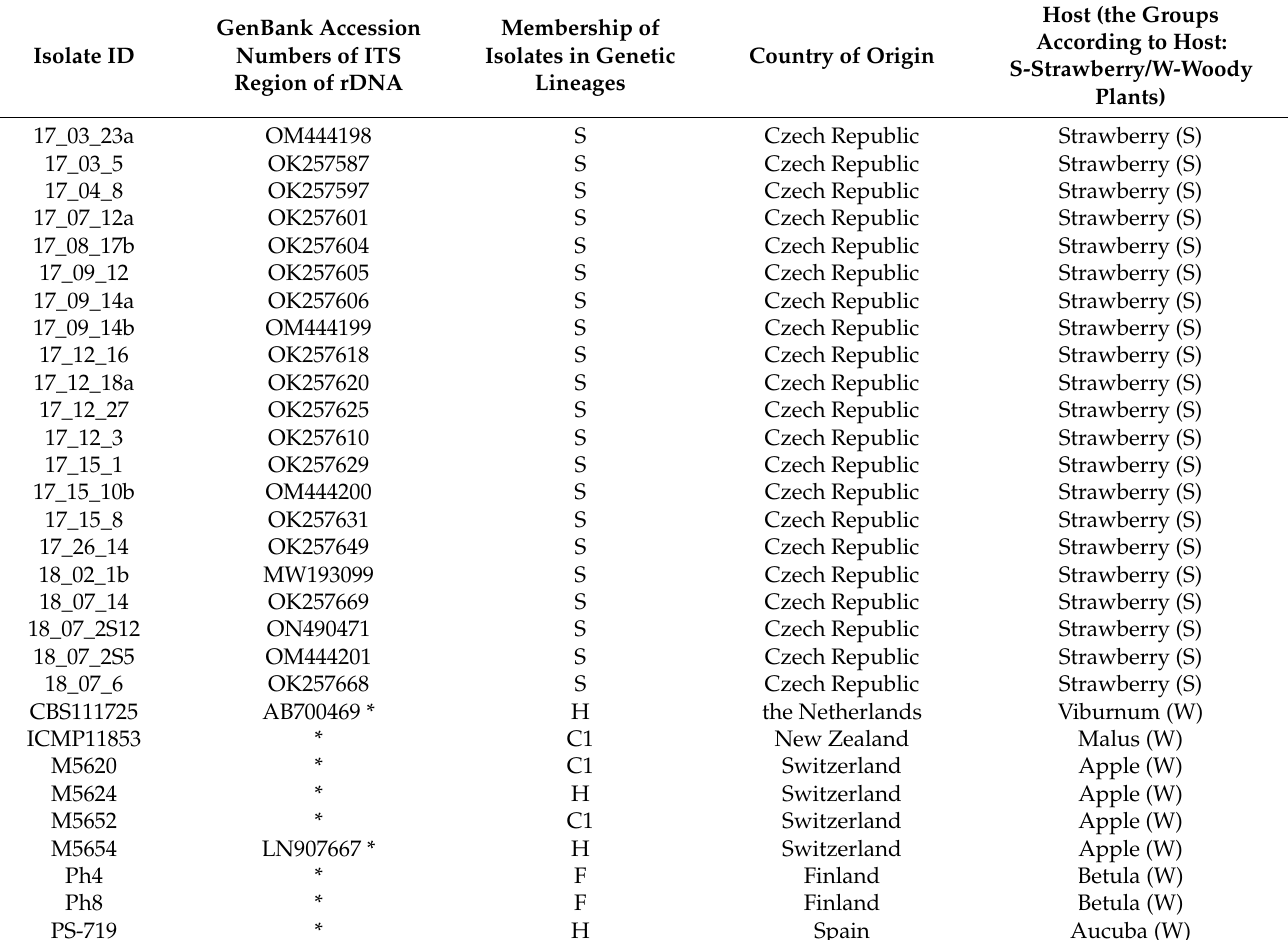
Table 1. Isolates of Phytophthora cactorum used in the current